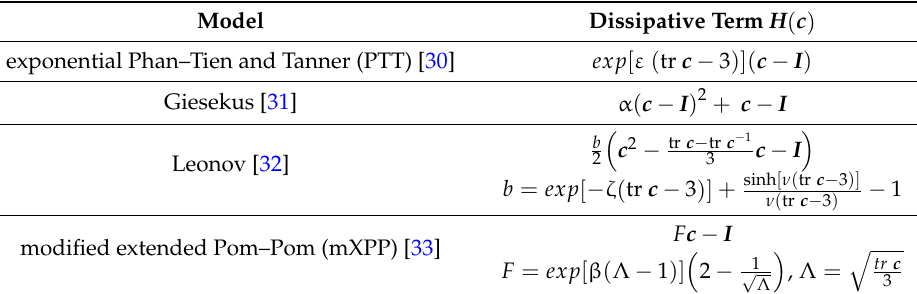
Table 1. The dissipative term H ( c ) for the individual differential constitutive models. Model